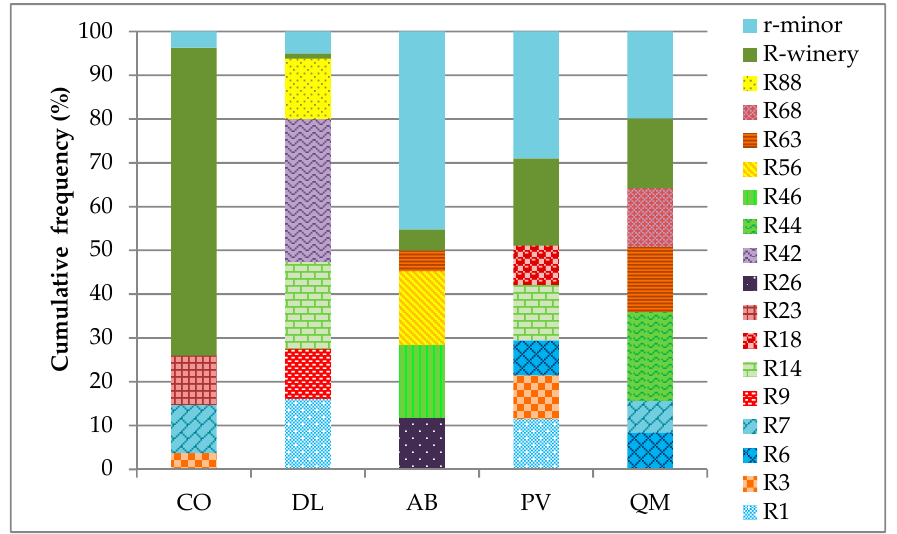
Figure 1. Cumulative frequency of Saccharomyces cerevisiae strains isolated from spontaneous fermentation in wineries from Galicia. R-winery: Σ frequencies of specific strains in a winery; r-minor: Σ frequencies of strains found at proportion < 5% in each winery.